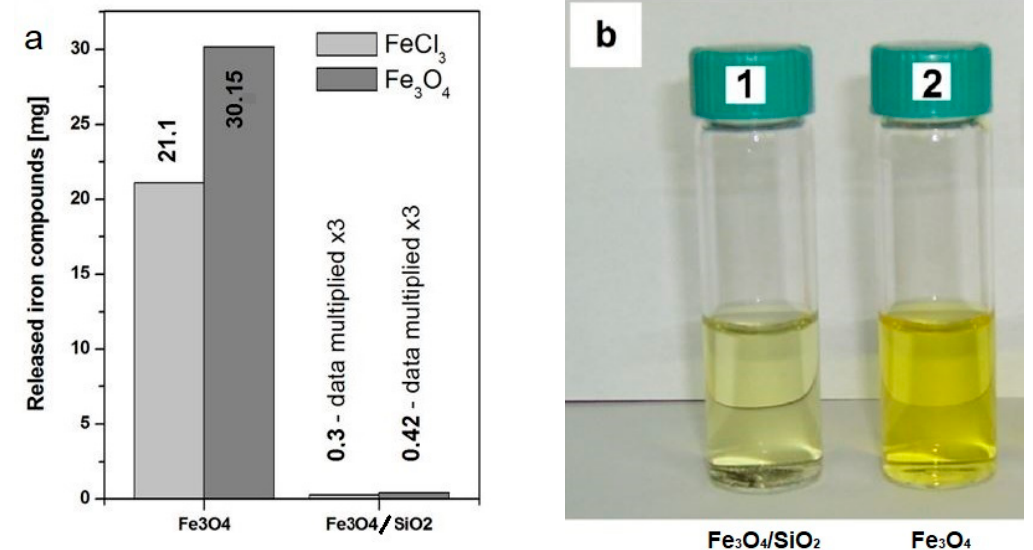
Figure 2. TEM micrographs of ( a , b ) iron oxide/silica (Fe 3 O 4 /SiO 2 ) core-shell structures (Reprinted with permission from [39]. Cophyright 2017 Elsevier ) and ( c ) the energy dispersive X-ray spectrometry (EDS) graph.